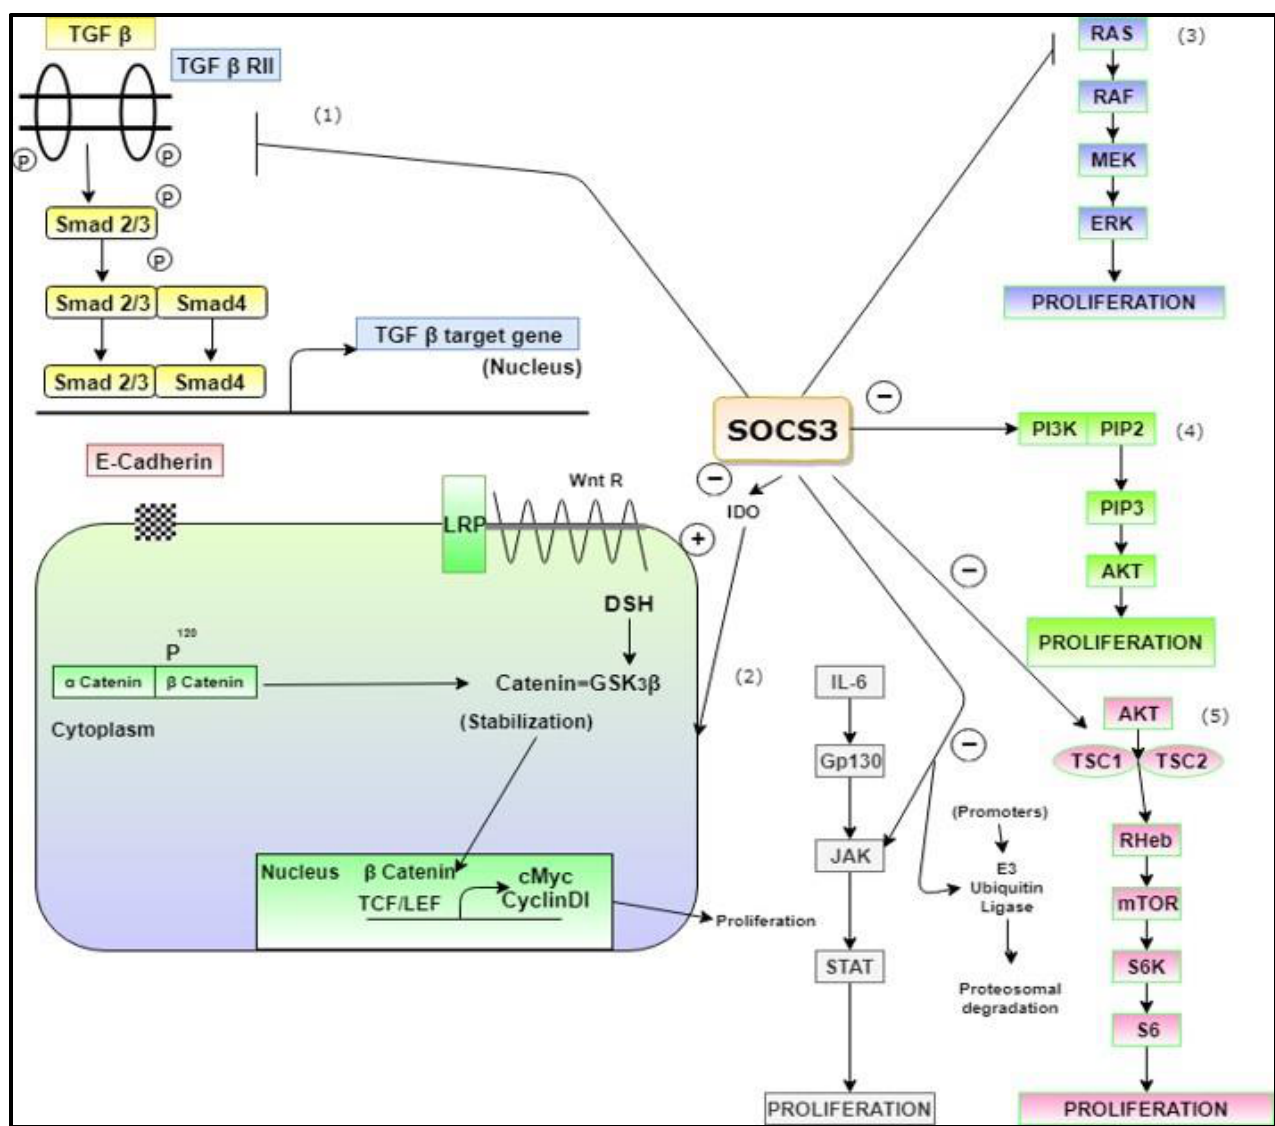
Figure 1: SOCS3 regulation of cancer cell proliferative mechanisms. SOCS3 affects various cancer proliferation pathways like TGF β, Ras/MAPK, mTOR, JAK/STAT, and Wnt